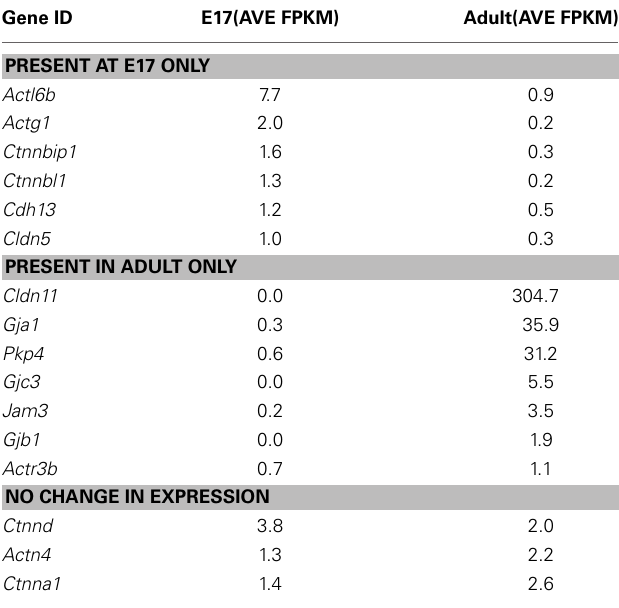
Table 5 | Junction-associated genes present only at E17 or adult or not different at these ages in mouse ventricular